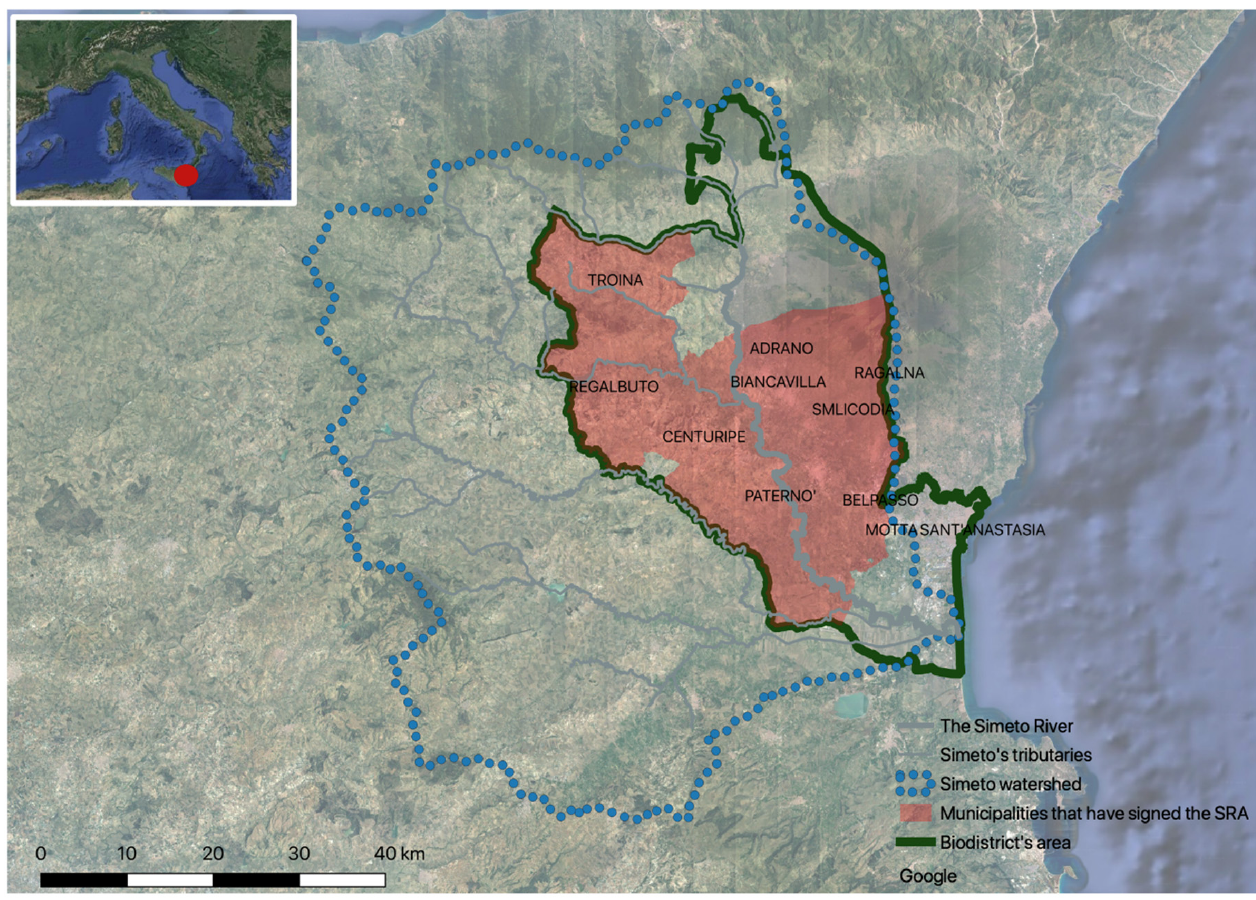
Figure 1. The Simeto river region .